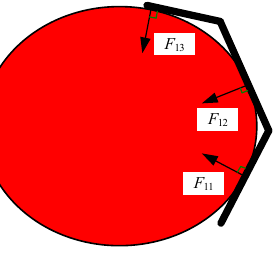
Figure 4. Schematic diagram of force analysis for grasping with a single fi nger.